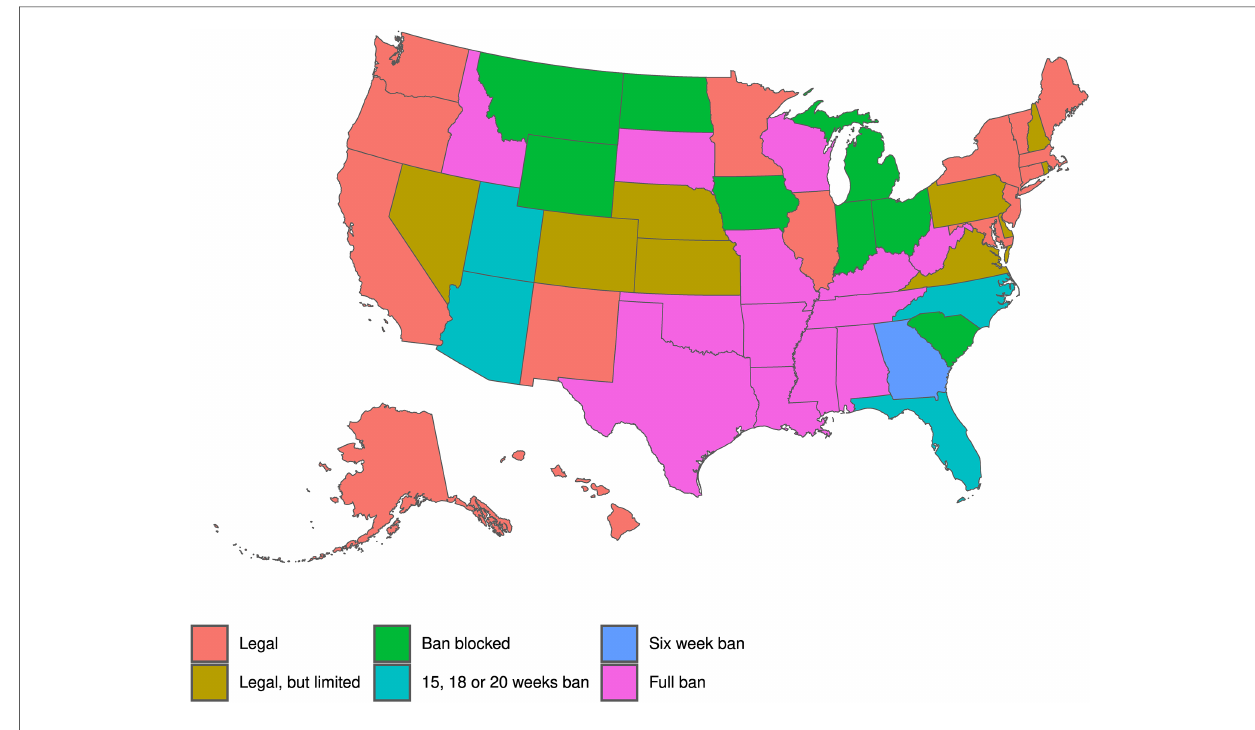
FIGURE 1 Abortion policies by state, following Dobbs v. Whole Women ’ s